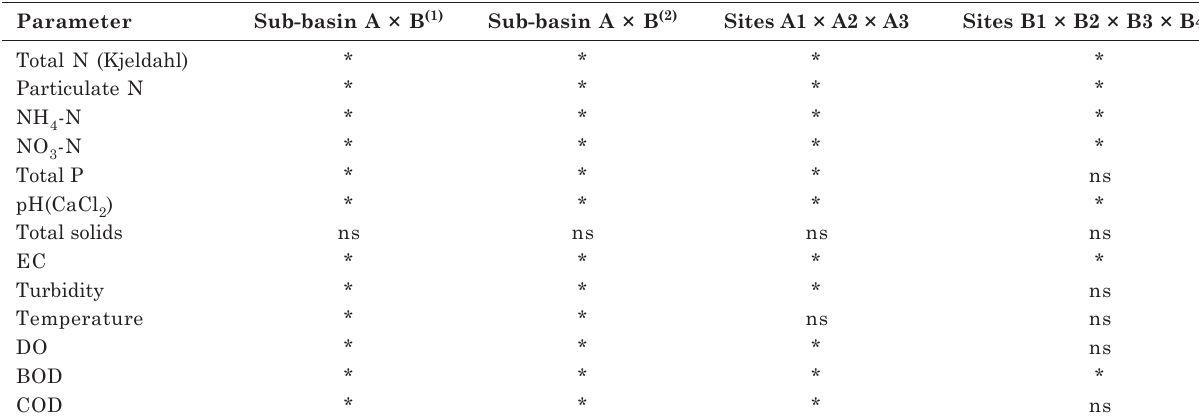
Table 5. Summary of statistical difference by the Kruskal-Wallis test (5 % probability) in sub-basins on water quality parameters in the Campestre catchment